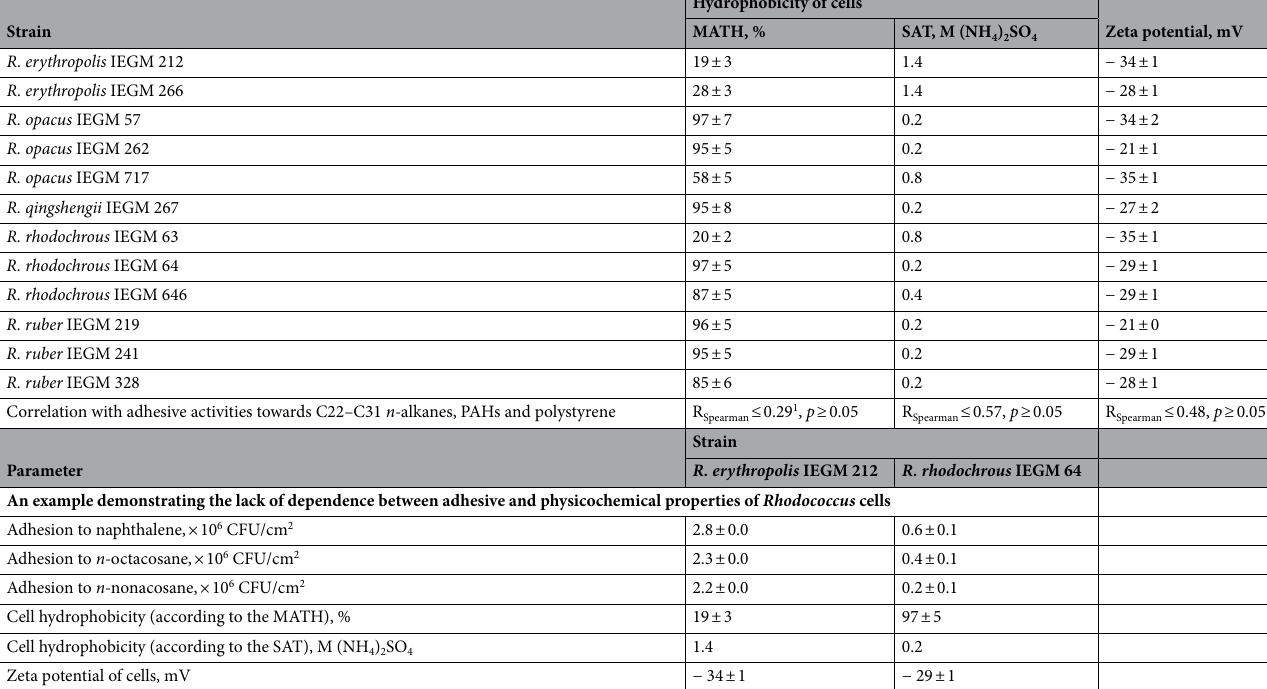
Table 2. Physicochemical properties of Rhodococcus cells and their influence on adhesion. Means ± standard deviations are shown for the MATH and the zeta potential values, and medians are shown for the SAT values. 1 Absolute values for the correlation coefficients are shown.